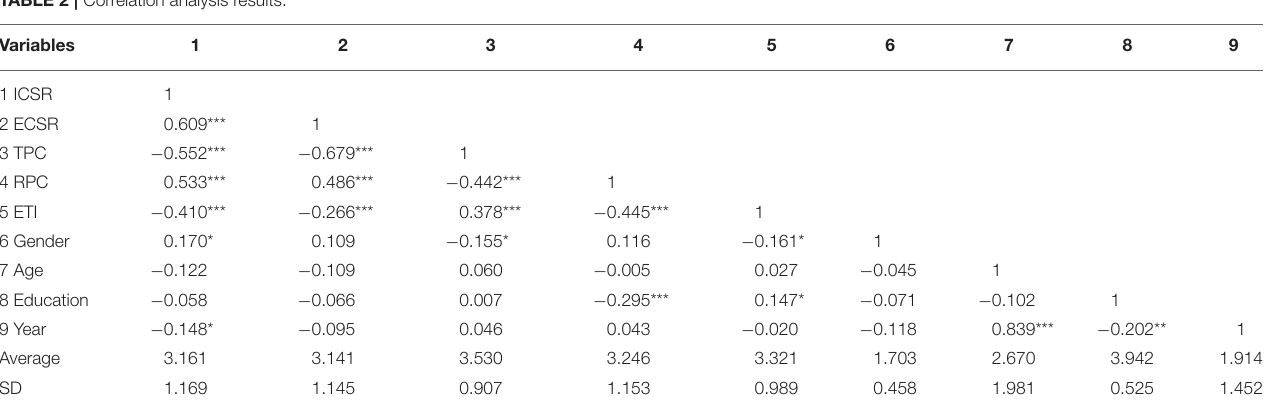
TABLE 2 | Correlation analysis